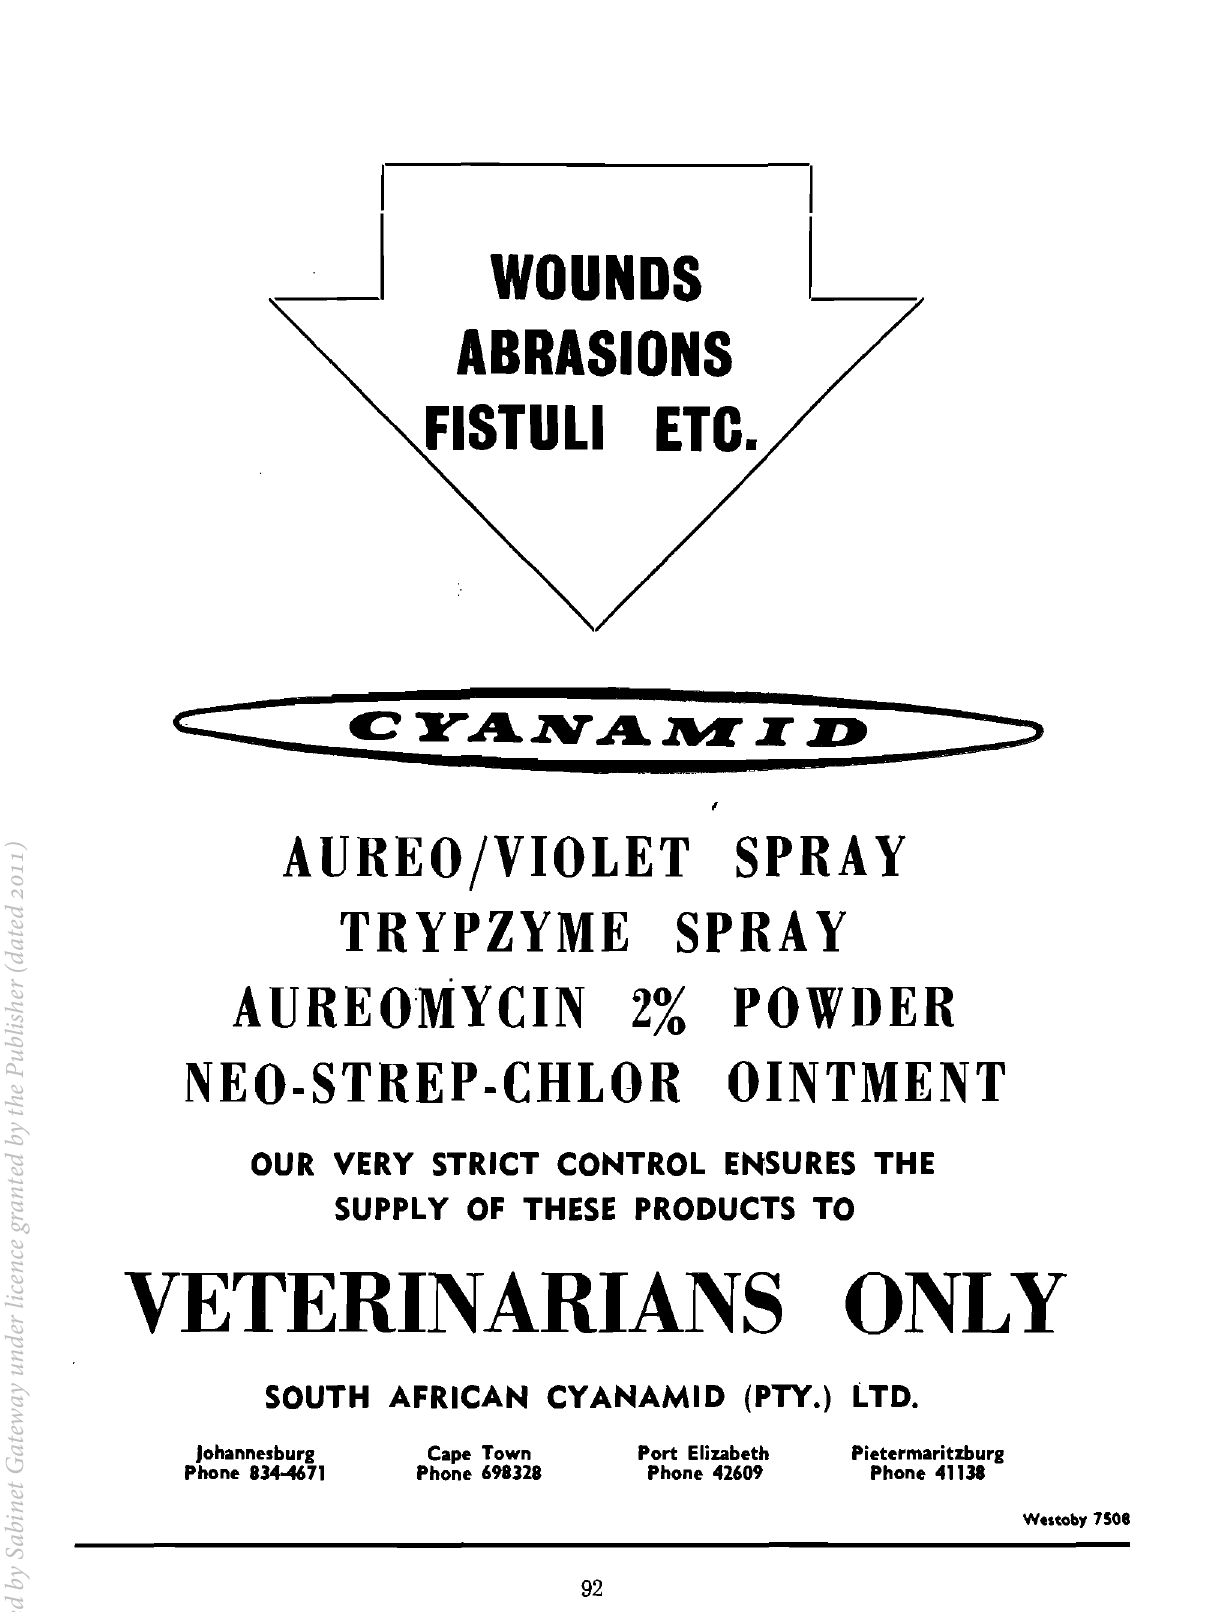
AUREOjVIOLET SPRAY TRYPZYME SPRA Y AUREO:MYCIN 2% POWDER NEO·STREP·CHLOR